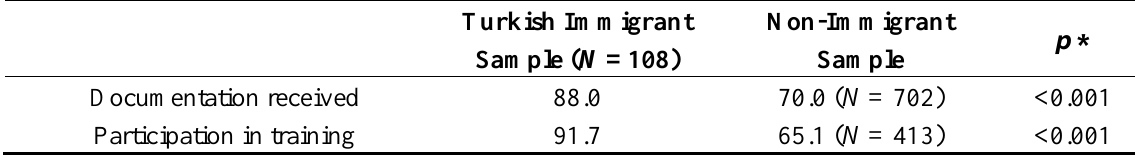
Table 3. Process quality: receipt of documentation sheets and participation in training